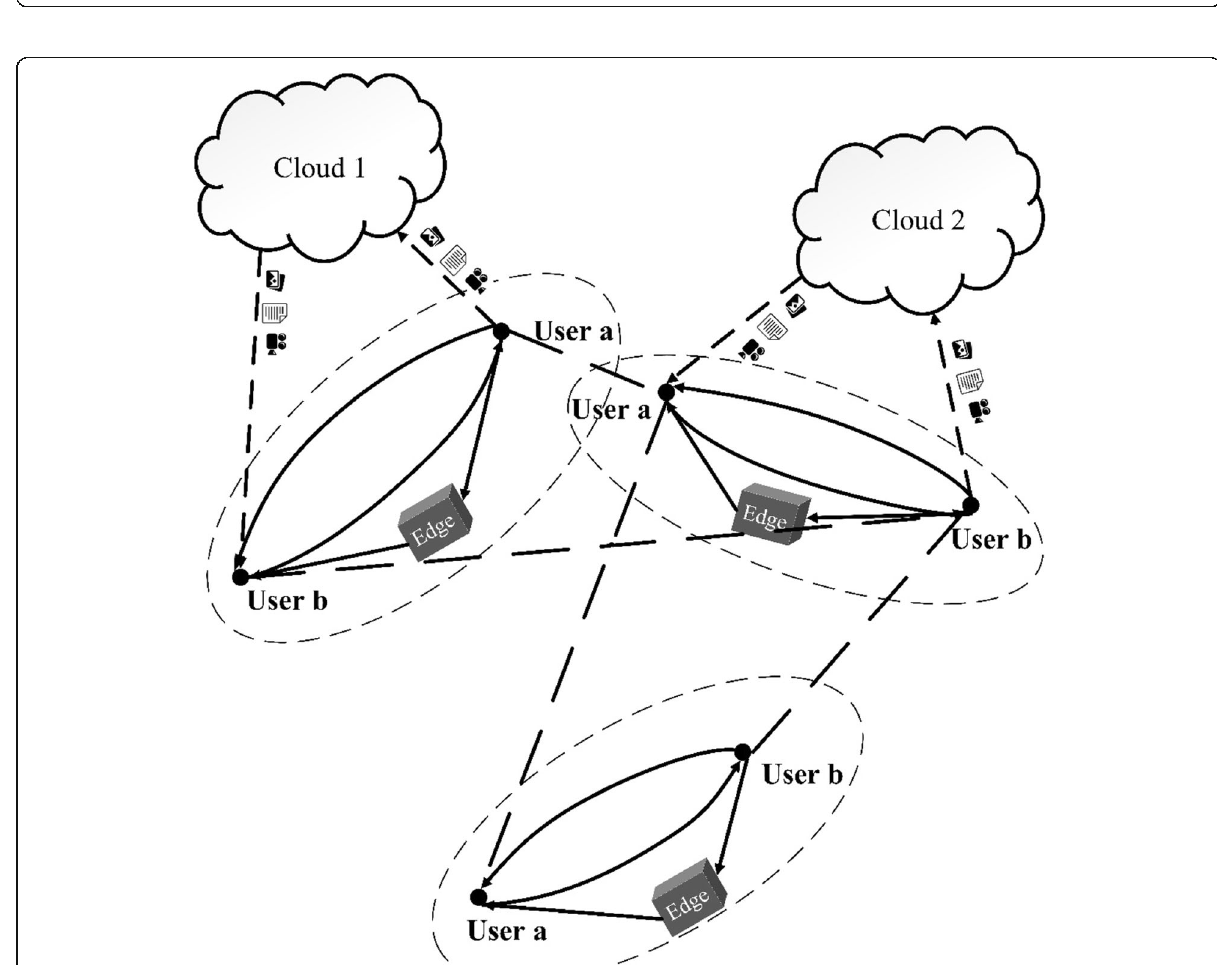
Fig. 5 Interaction mode of users based on Edge computing